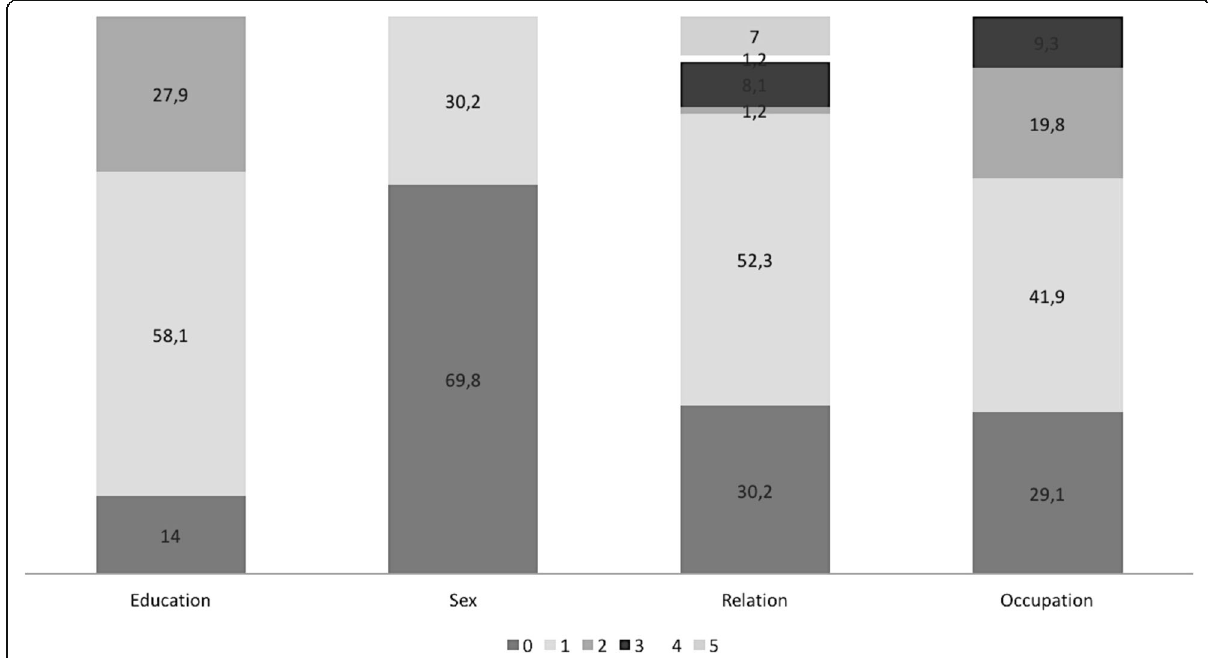
Fig. 2 Socio-demographics characteristics. For Education Level: Primary (0), Secondary (1) and Higher Education (2). For Sex: Female (0) and Male (1). For Relation: Father (0), Mother (1), Siblings (2), Grandparents (3), Uncle/Aunt (4) and non-family (5). For Occupation: Housewives (0), Dependent Worker (1), Independent Worker (2) and Unemployed